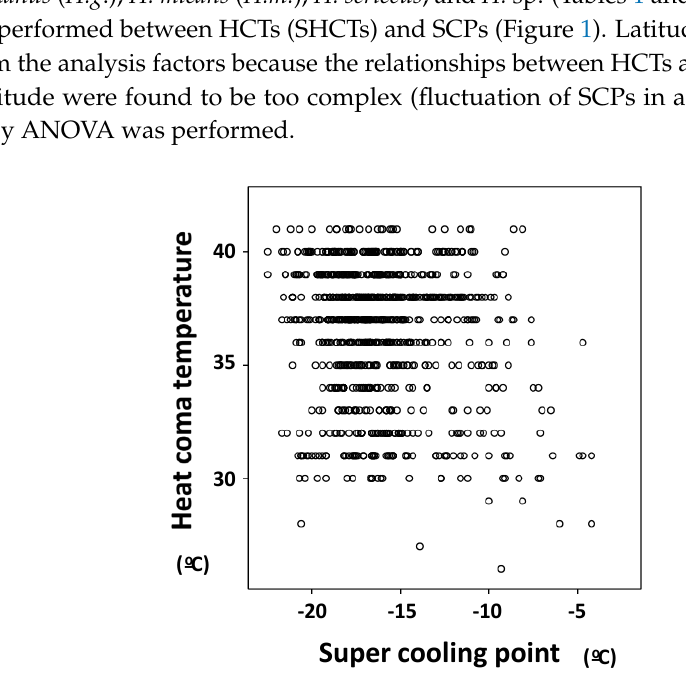
Figure 1. Negative correlation between heat coma temperatures (HCTs) and super cooling points (SCPs) in four species of oceanic sea skaters— Halobates micans , H. germanus , H. sericeus , and H. sp.—inhabiting temperate to tropical regions of the Indian and Pacific Oceans (Pearson’s correlative analysis: r = −0.178, p < 0.001, n = 1004). Table 1. Comparisons of heat coma temperatures (HCTs) and super cooling points (SCPs) between five instars of larvae and adults and between species of individuals of Halobates in the Pacific and Indian